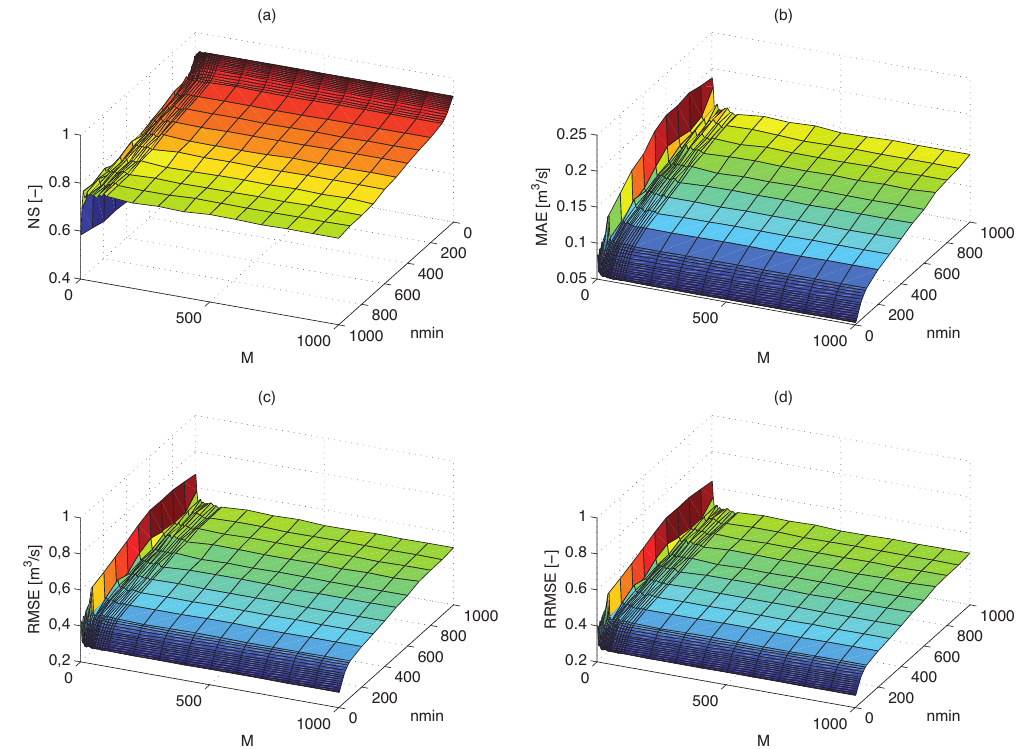
Fig. 3. Values of NS (a) , MAE (b) , RMSE (c) and RRMSE (d) as a function of n min and M over the testing subsets for Canning River (average over 10 data groups).